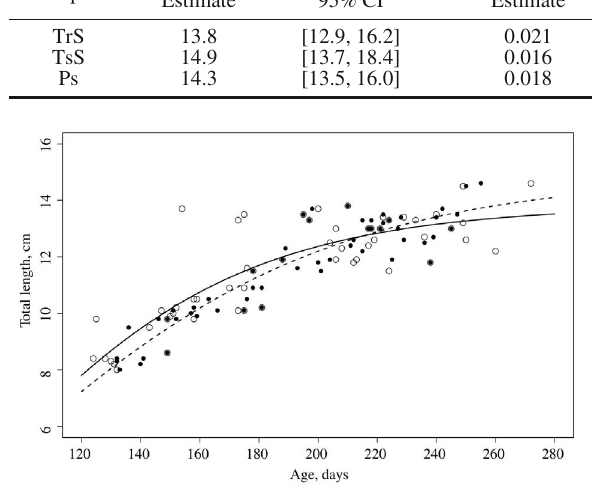
Table 4. – Coefficients of the Gompertz growth model for the samples. TrS, training sample; TsS, test sample; Ps, pooled sample. Samples